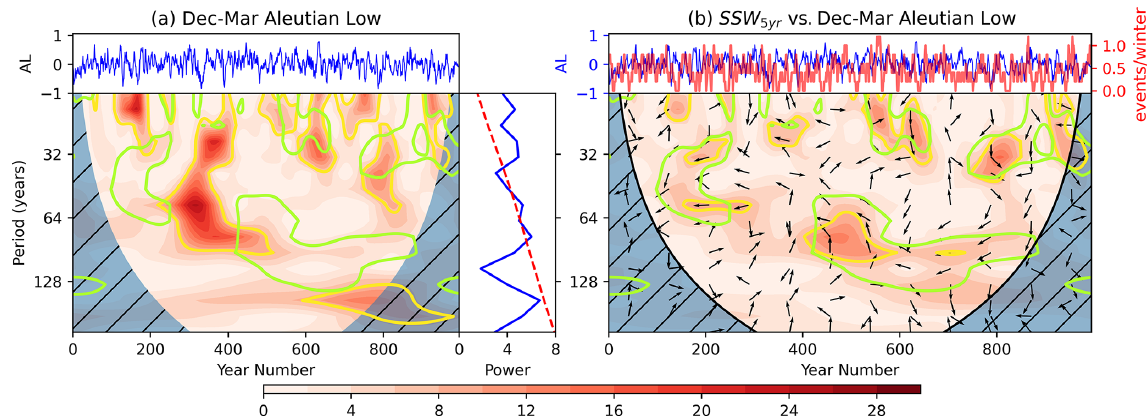
Figure 9. As Fig. 8 for the December–March Aleutian Low index smoothed with a 5-year window. (a) AL time series and associated wavelet power spectrum. (b) Cross-power spectrum between AL and SSW 5 years